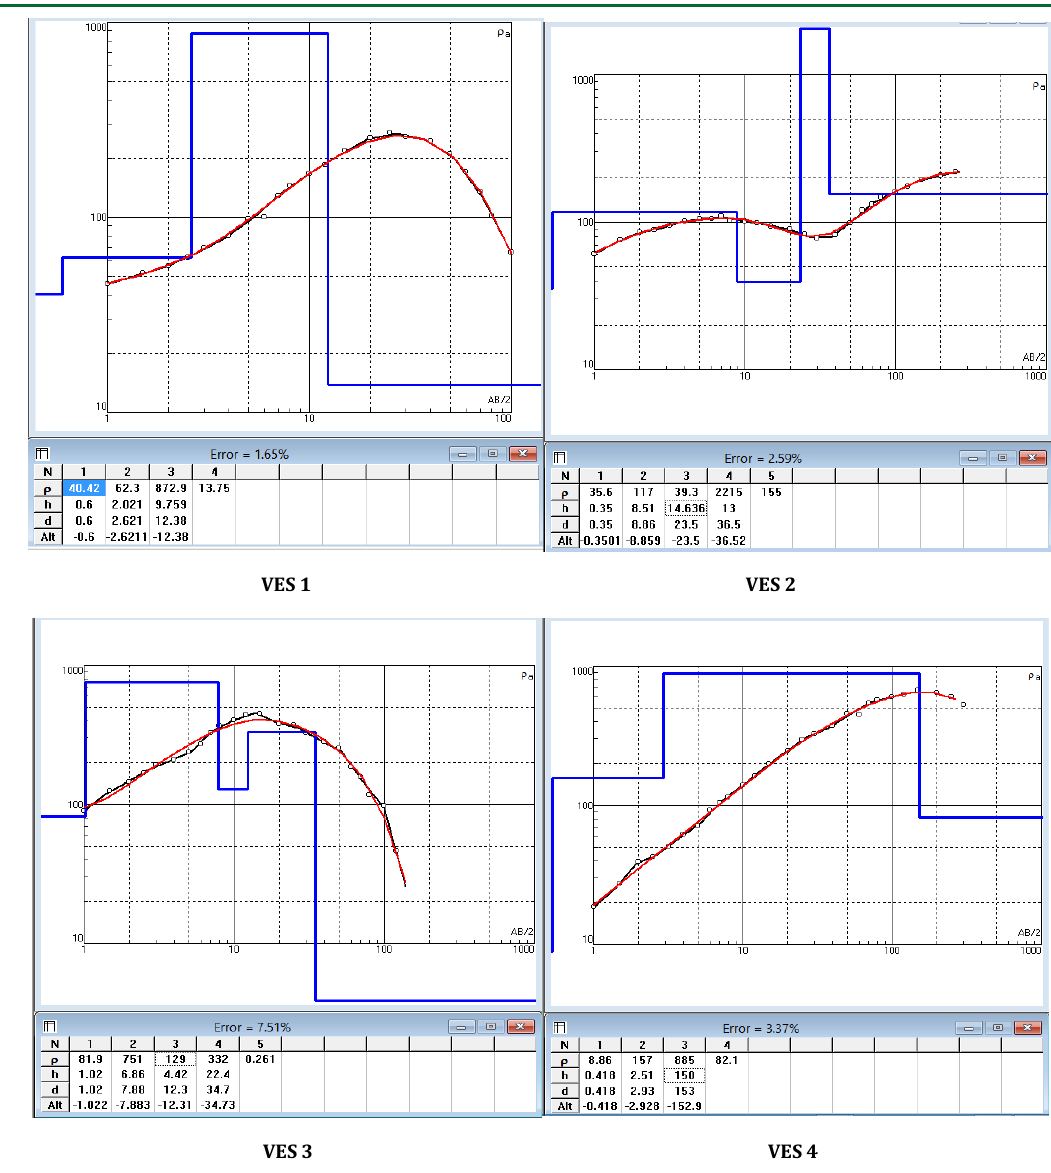
Figure 6: Four examples out of 16 of Stations of Interpreted Resistivity